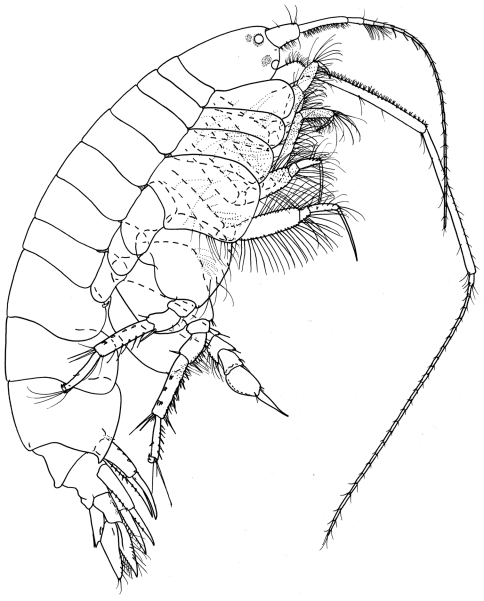

Ampelisca malakalensissp. n., male.